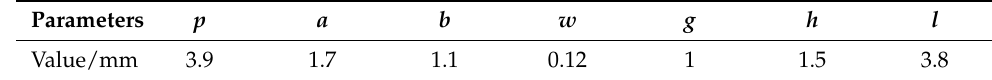
Figure 1. An illustration of the polarization rotator. Left panel: a demonstration of x -polarized wave incident on the peri- odical structure with emergence y -polarized wave; right panel: the unit cell of the polarization rotator. Table 1. The key parameters for the unit cell. Table 1. The key parameters for the unit cell.